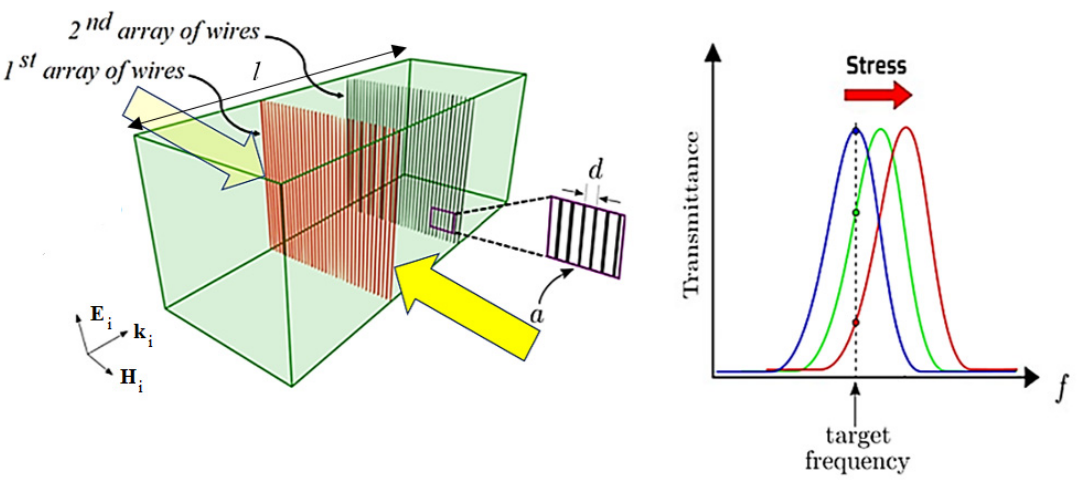
Figure 1. Overview of the working principle of the proposed reconfigurable filter.